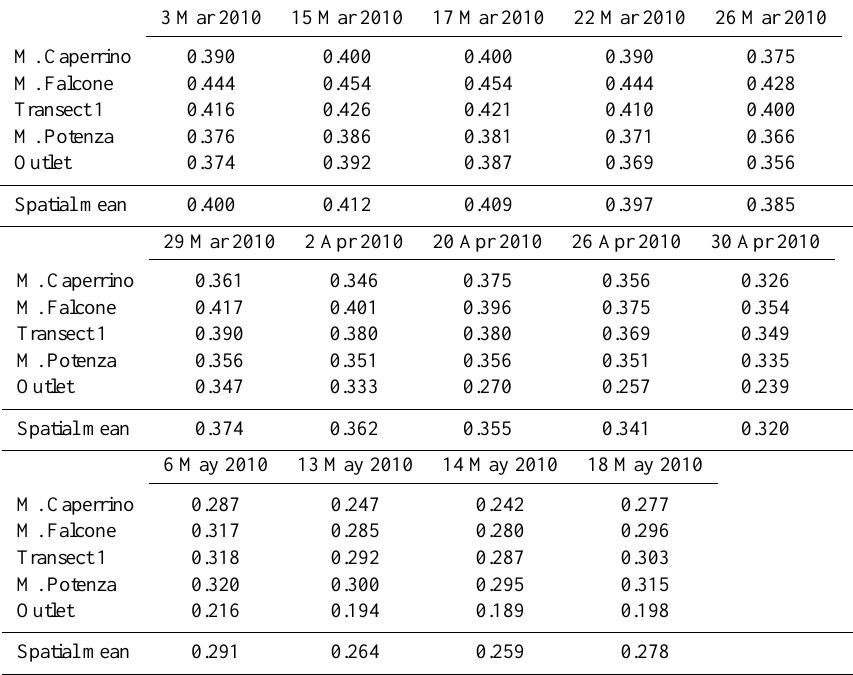
Table 2. Simulated values of the SM m 3 m − 3 obtained by DREAM model during the period from 3 March 2010 to 18 May 2010 in each of the monitored